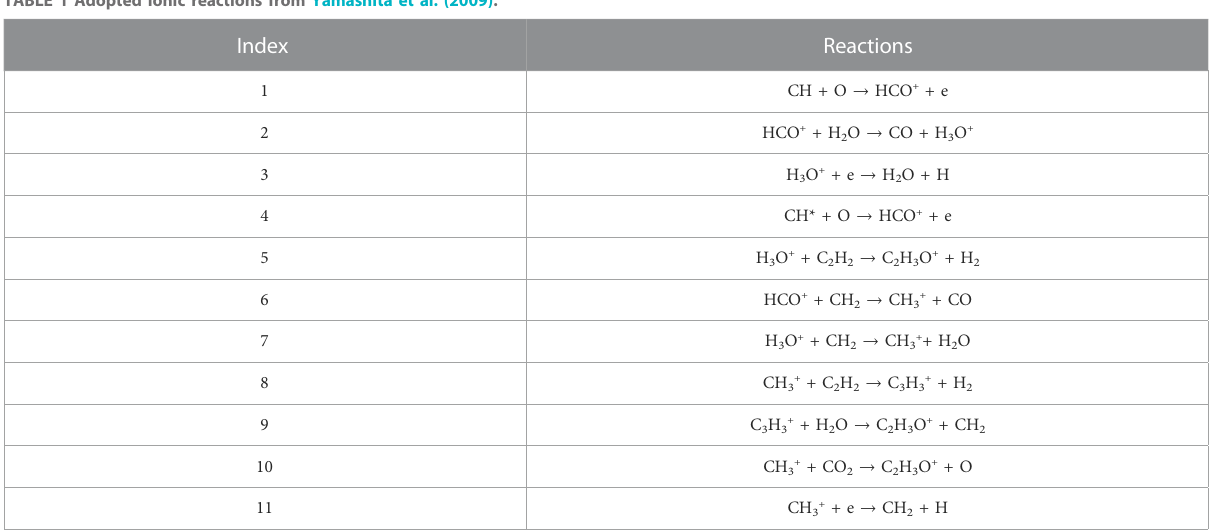
TABLE 1 Adopted ionic reactions from Yamashita et al.